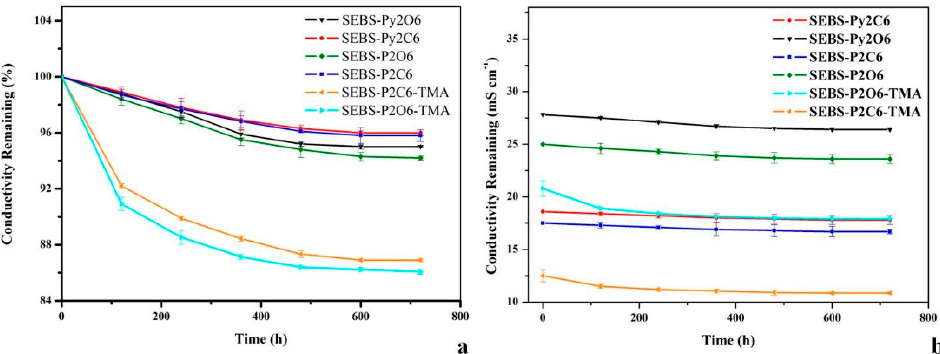
Figure 5. ( a ) Conductivity retention and ( b ) ionic conductivity of SEBS-P206 membranes after stability test in KOH at 90 °C.